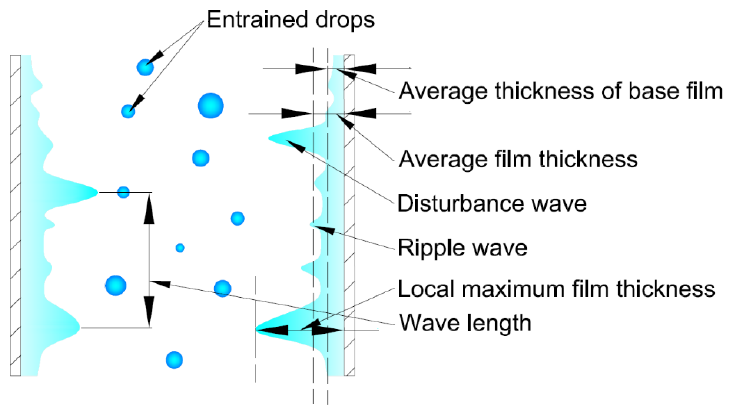
Figure 11. Structure of a typical two-phase annular flow in vertical pipe showing the disturbance waves, ripple waves, liquid film, and entrained droplets.